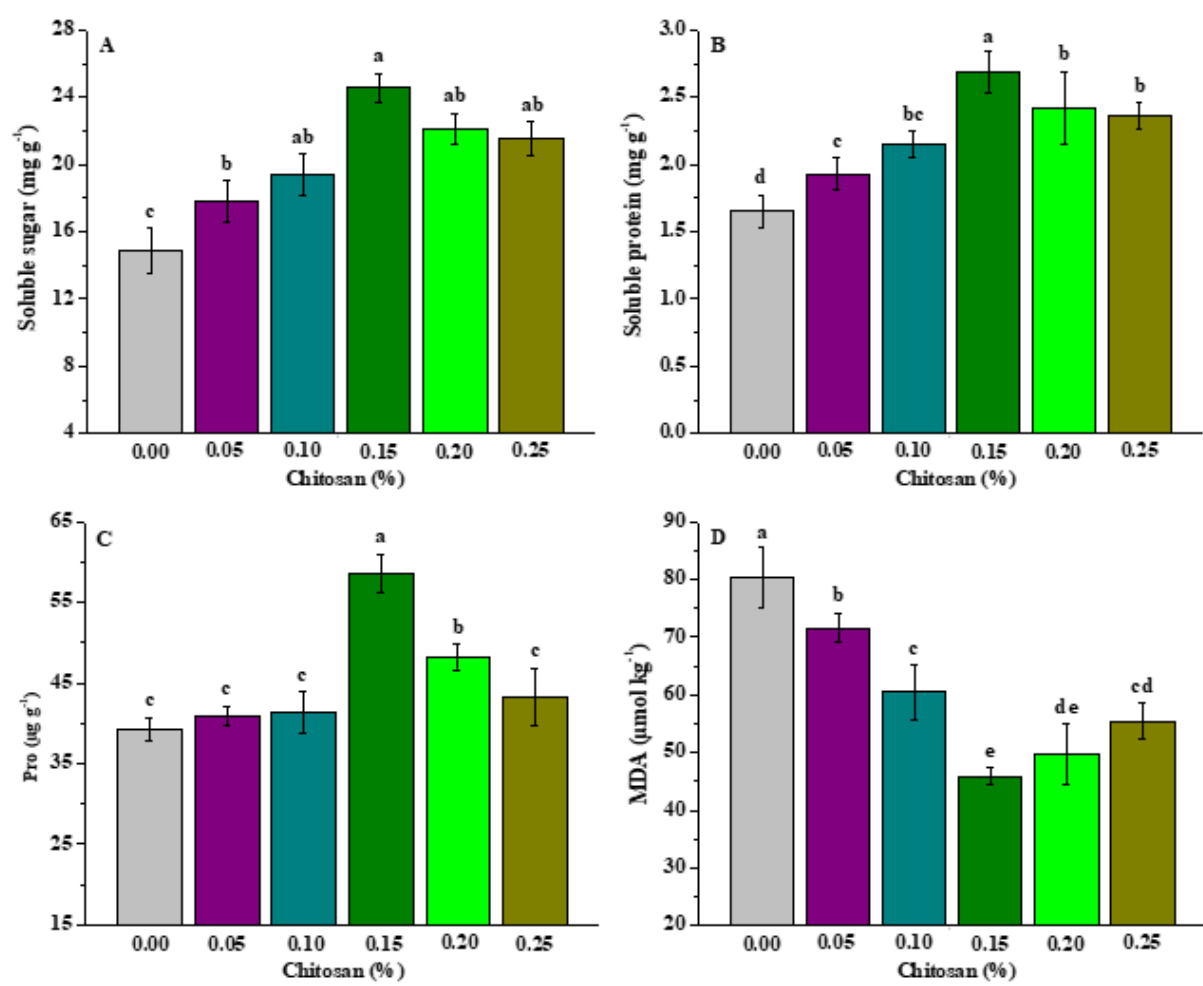
Figure 2. Influences of chitosan soaking on soluble sugar ( A ), soluble protein ( B ), Pro ( C ), and MDA ( D ) of P. grandiflorus leaves. The SD of three replicates was indicated by error bar. A one-way analysis of variance (ANOVA) followed by Duncan’s test was used, and the significant differences at a 5% level ( p < 0.05) in the six treatments are represented by different letters.